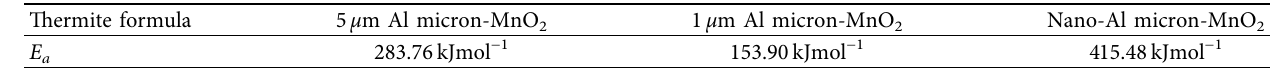
p : (a) 5 μ m Al +micron-MnO 2 thermite, (b) 1 μ m Al +micron-MnO 2 thermite, and (c) Table 2: The figures of activation energy E a .